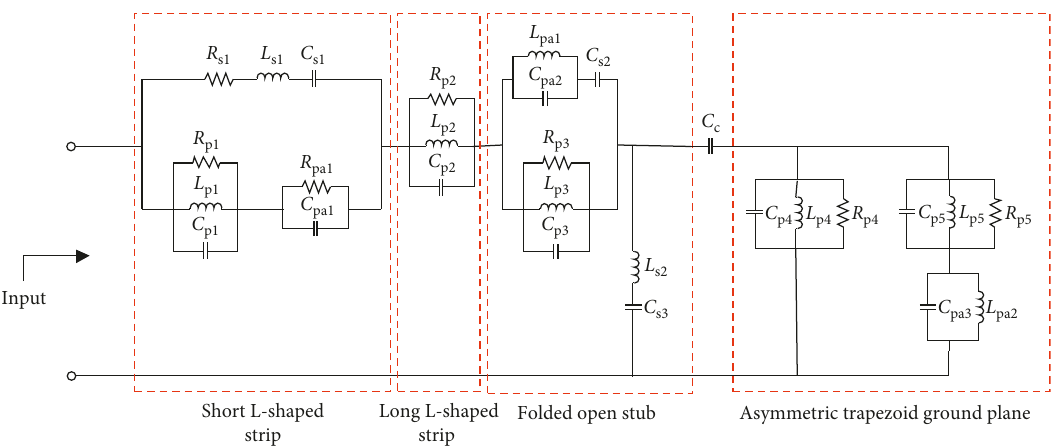
Figure 6: Comparison between the simulated | S (b) Antenna1, (c) Antenna2, (d) Antenna3, and (e) the proposed antenna.